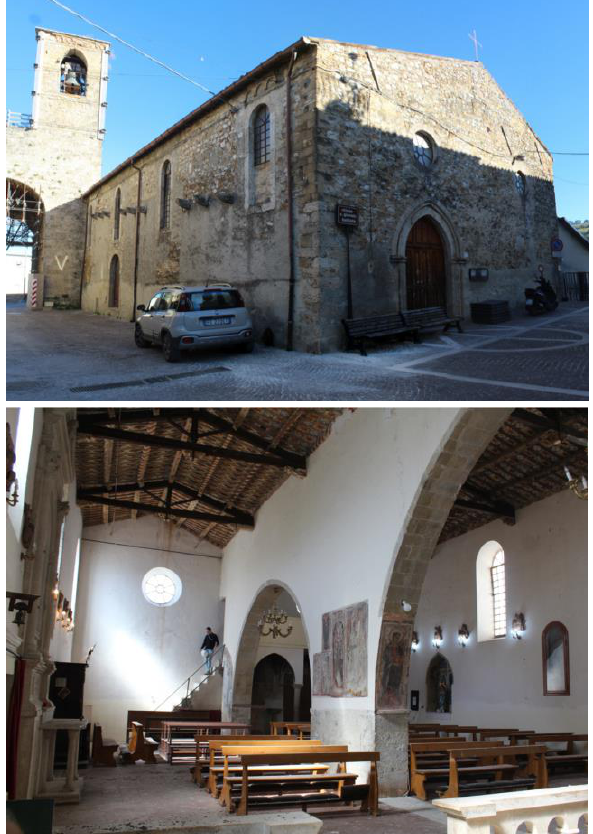
Figure 1 . The complex of St. John the Baptist in Campli